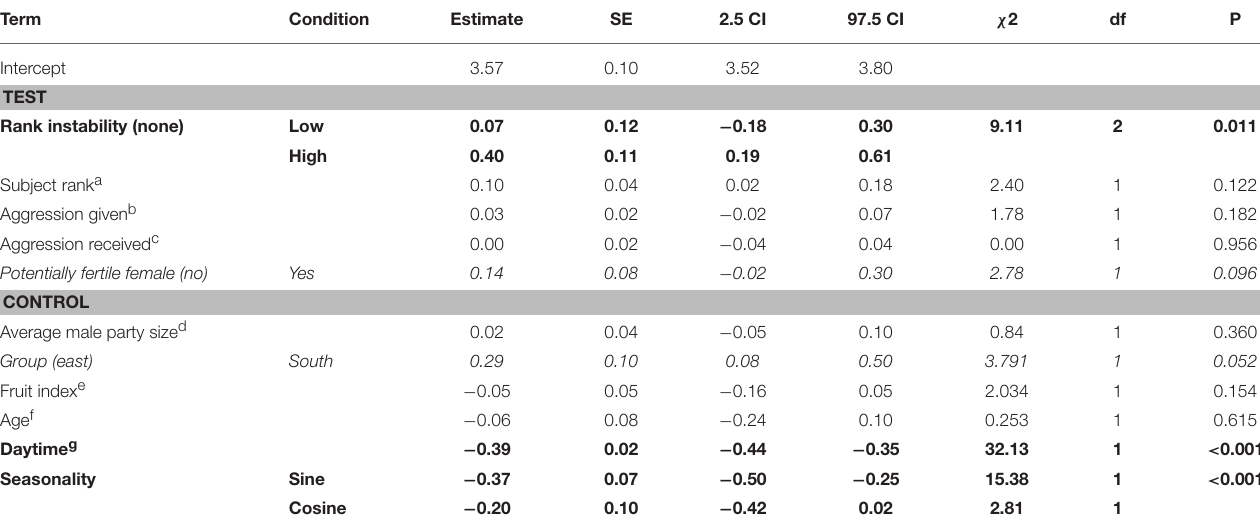
TABLE 3 | Effect of dominance rank, aggression rates, rank instability and presence of potentially fertile females on male chimpanzees’ urinary cortisol levels (model 1). Term